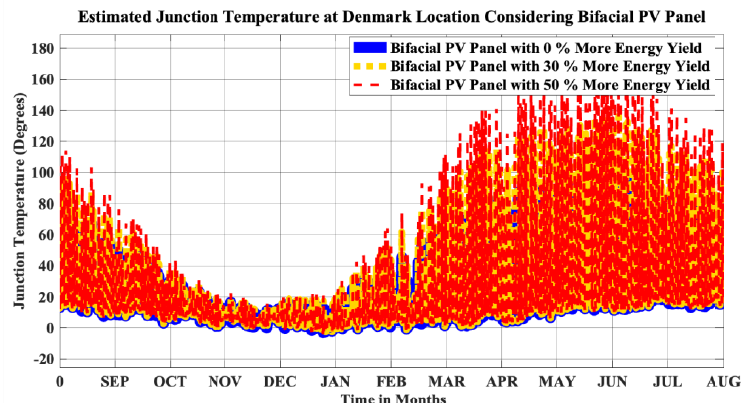
Figure 16. One-year estimated junction temperature at the location in Denmark.